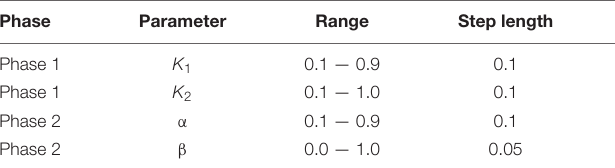
TABLE 2 | Parameter